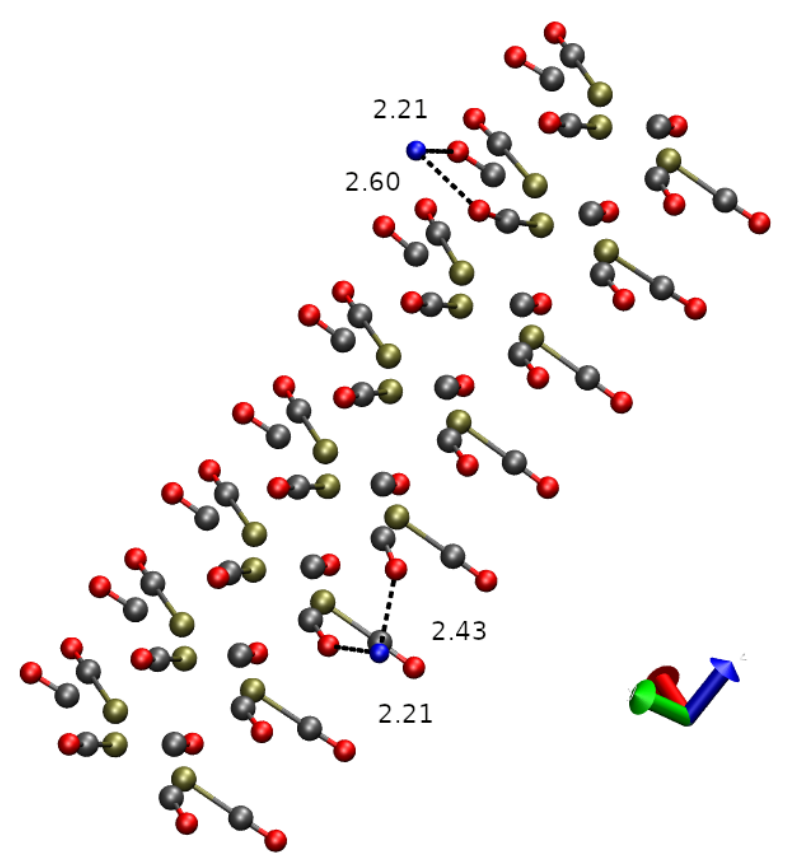
Figure 7. Final configuration (conf. 150 in Figure 6). Na atoms are displayed as blue spheres. The shortest distances between Na and O atoms in the nano-wire are displayed. For clarity, bonds are drawn when distance between atoms in the pair are shorter than 1.6 Å.